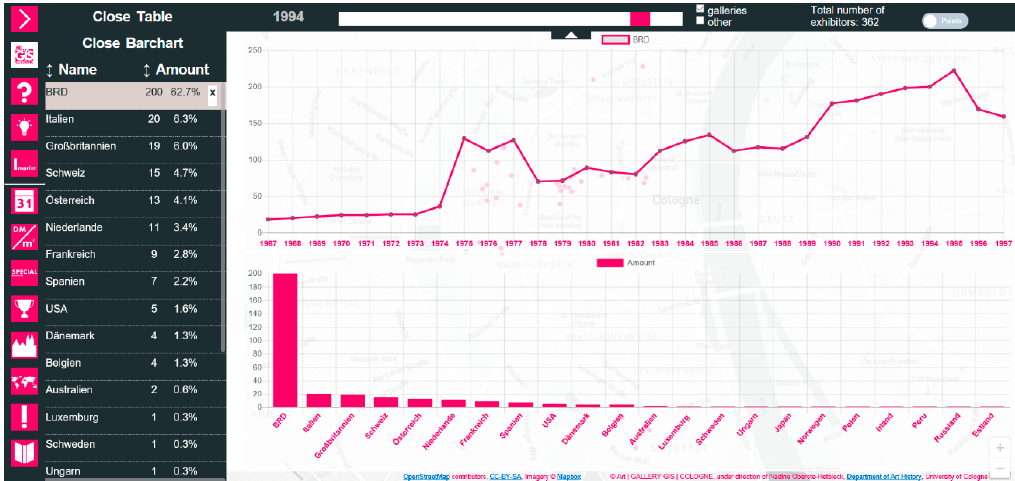
Figure 2. ART|GALLERY GIS|COLOGNE, 1994, number of galleries, art dealerships, and publishers of limited editions from Federal Republic of Germany who participated in Kunstmarkt Köln->ART COLOGNE 1994 sorted by country of origin by number and percentage. Three ways of visualization: tabular list, line diagram, and bar chart. Used by permission. © ART|GALLERY GIS|COLOGNE.